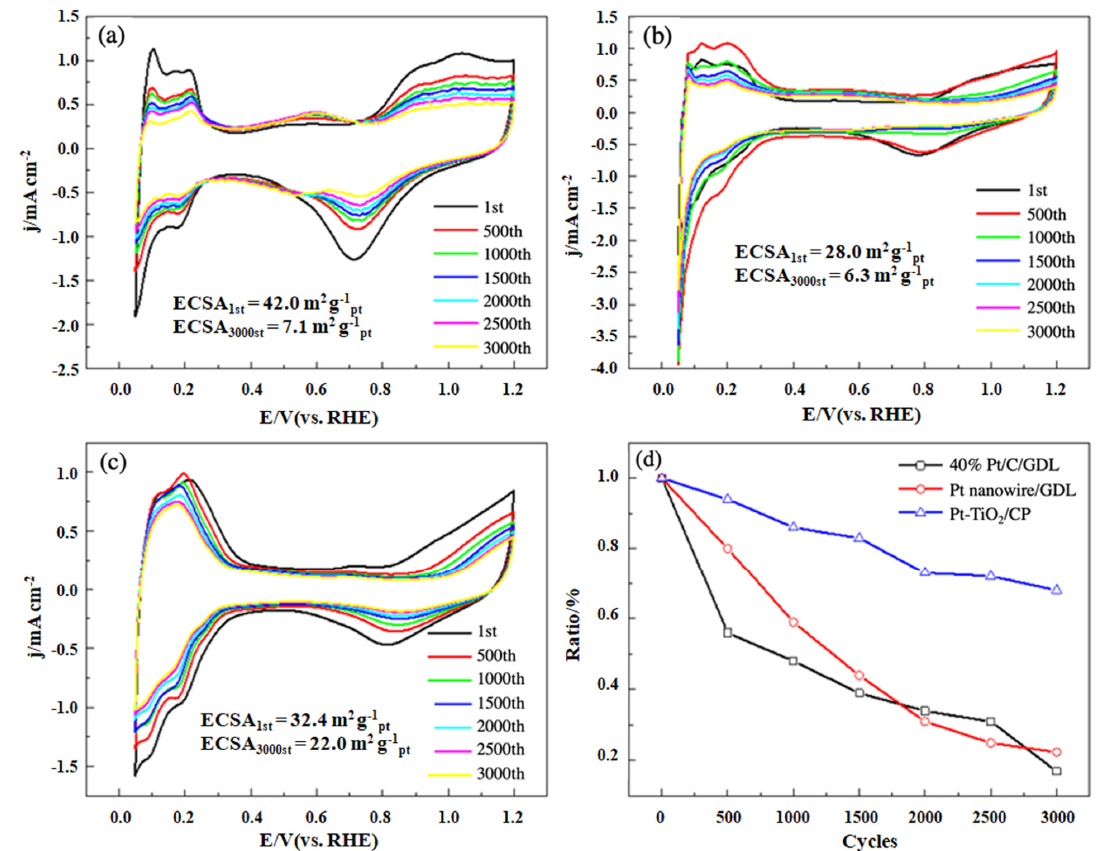
图 6 Figure 6. CV curves of conventional Pt/C [33], Pt nanowire, and Pt-TiO 2 @C ordered cathode before and after 3000 ADT cycles ( a – c ) and the decay of ECSA ( d